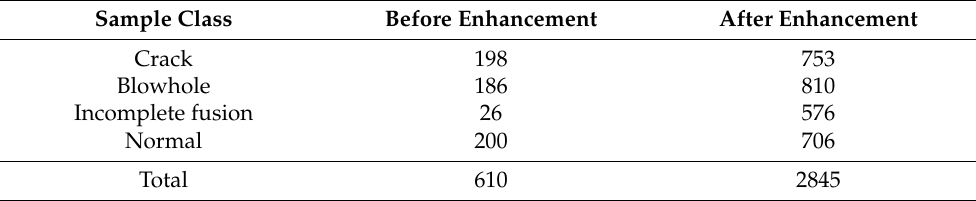
Figure 3. Comparison of defect images before and after enhancement. Table 1. Sample distribution of weld surface defect